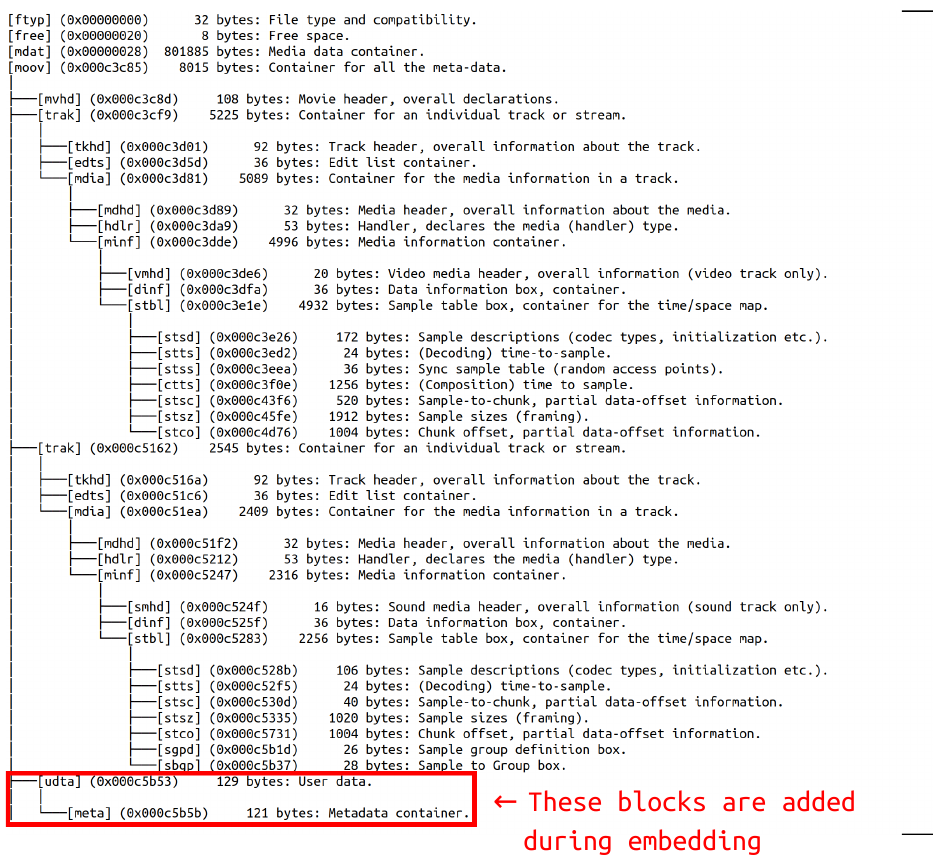
Figure 6. Example of metastego